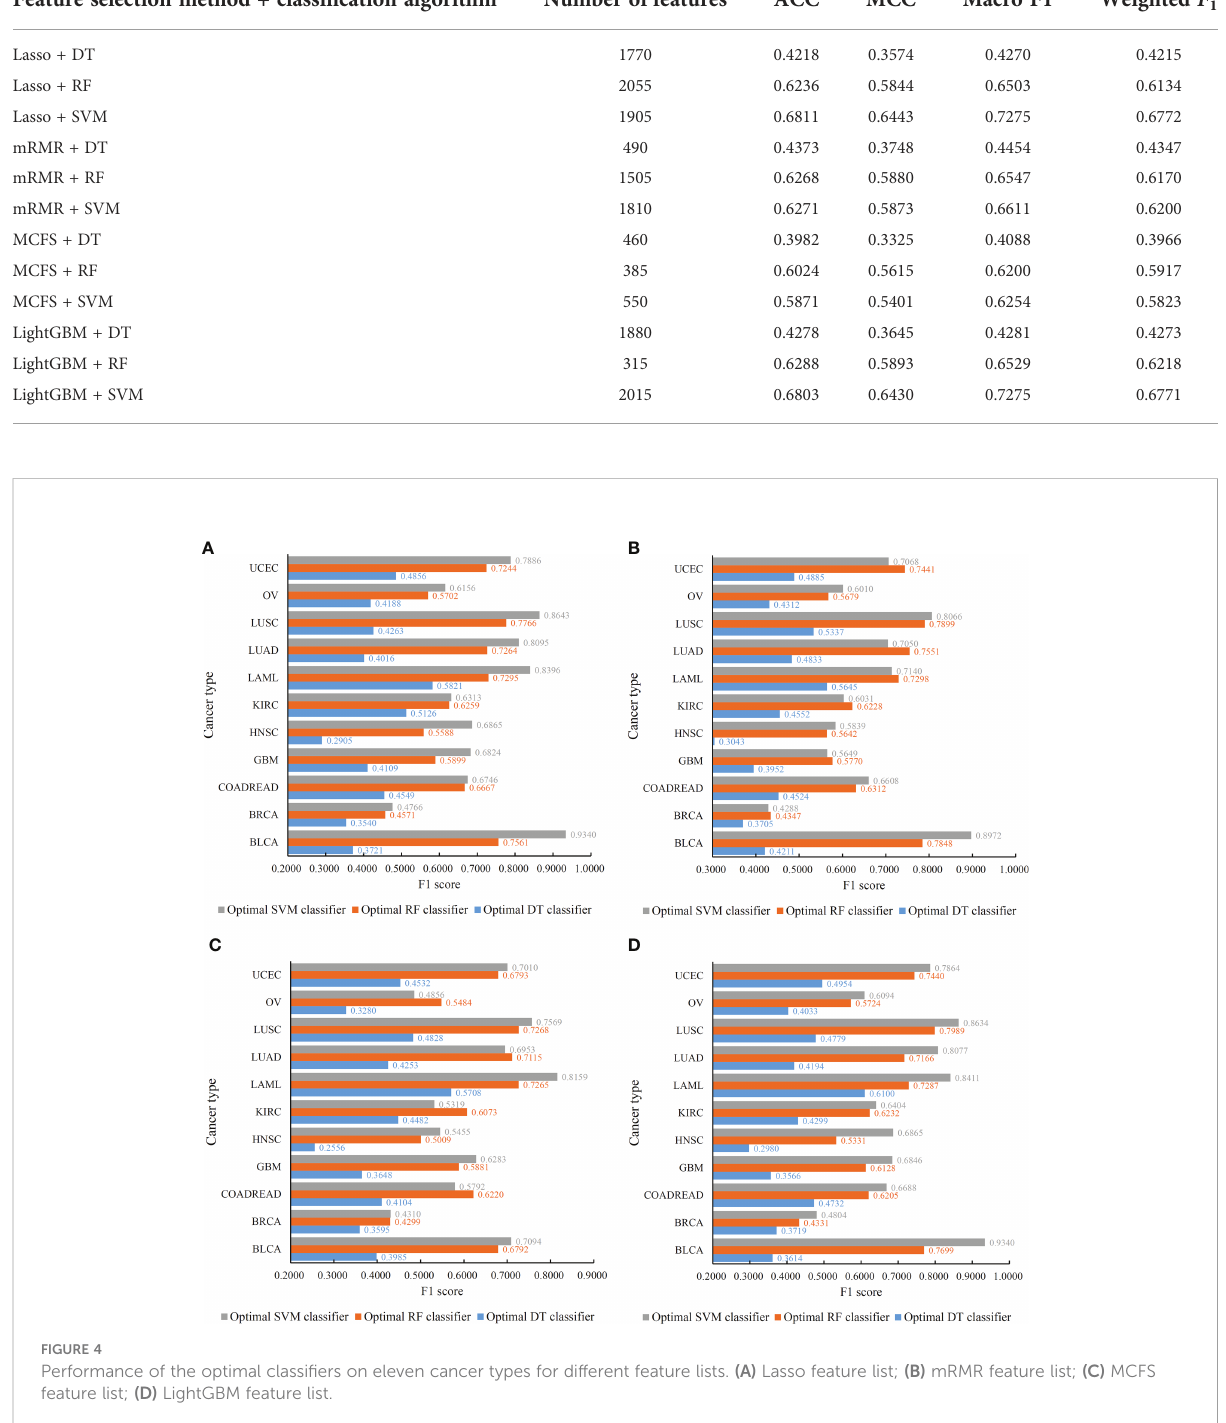
TABLE 2 Detailed performance of the optimal classi fi ers for different feature selection methods and classi fi cation algorithms. Feature selection method + classi fi cation algorithm